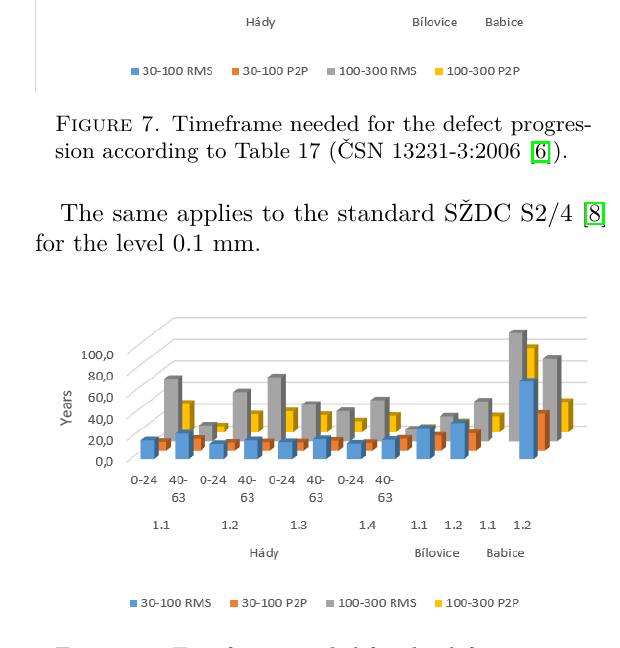
Figure 8. Timeframe needed for the defect progres- sion according to standard SŽDC S2/4 [8] for the level 0.1